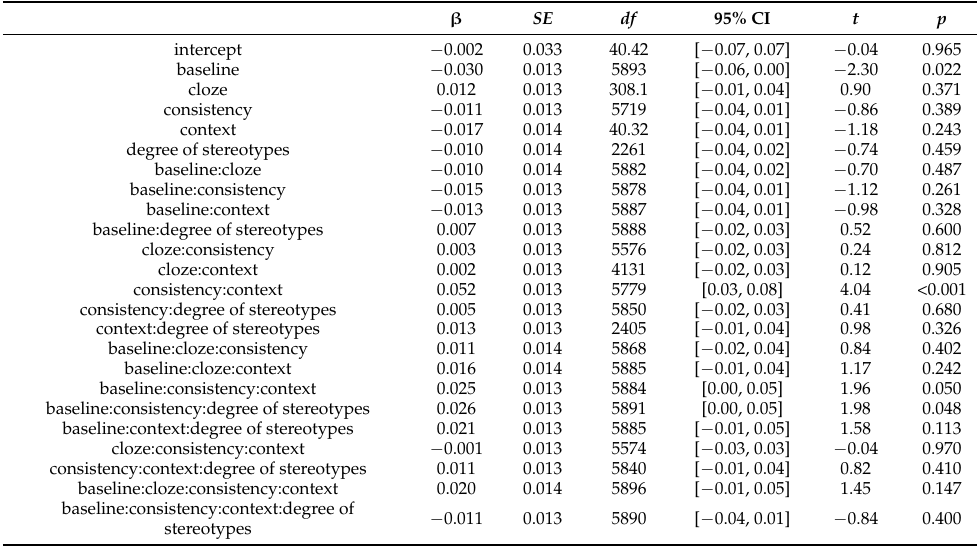
Table 3. Estimates of fixed effects in the LN (800–1000 ms) time window.